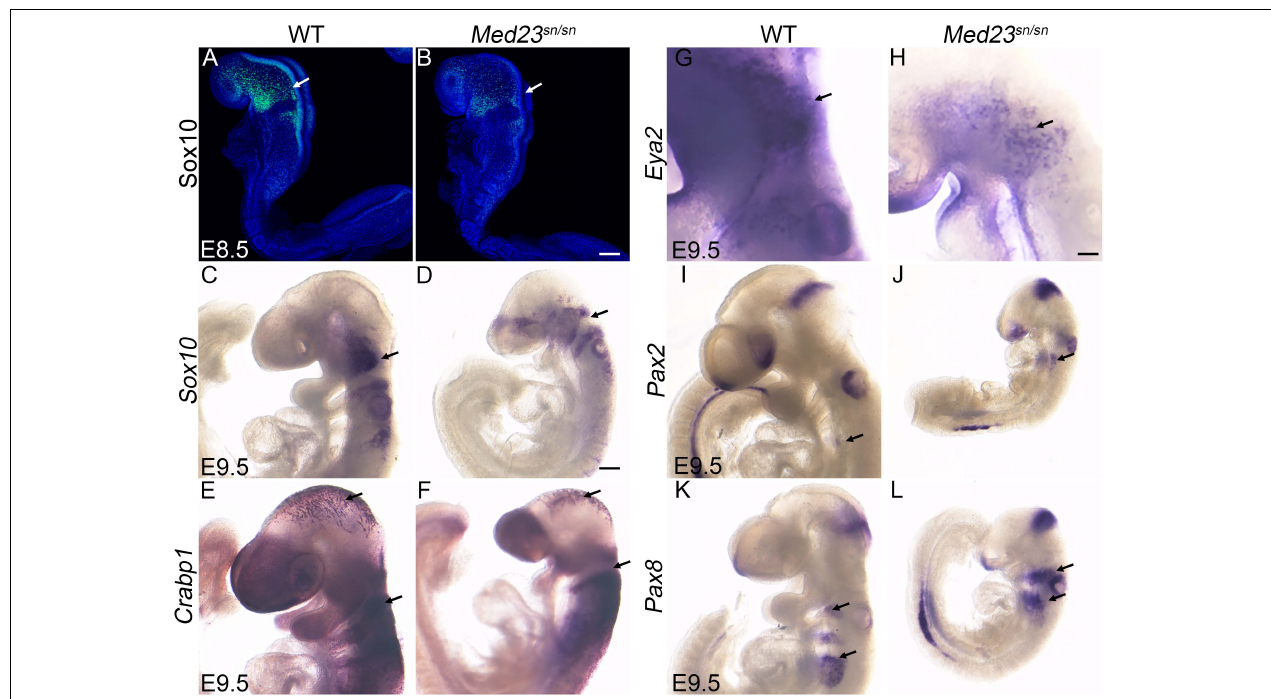
FIGURE 3 | Med23 sn / sn mutants display neural crest cell and placodal defects. (A–D) Sox10 expression in E8.5 and E9.5 control and Med23 sn / sn embryos shows reduced Sox10 + cells entering the cranial ganglia region near the 1 st branchial arch and around the otic vesicle in Med23 sn / sn embryos. (E,F) Crabp1 ISH reveals proper neural crest cell migration in the cranial and trunk regions of E9.5 control and Med23 sn / sn embryos. (G,H) Eya2 expression in control and Med23 sn / sn embryos shows proper formation of anterior pre-placodal area. However, very few Eya2 + cells are observed in the trigeminal and epibranchial regions of Med23 sn / sn embryos (arrow, H ). (I,J) Pax2 + cells are present in the optic, otic, and isthmus of both control and Med23 sn / sn embryos. (K,L) Pax8 + cells are present but loosely organized in the epibranchial region, otic placode and isthmus of Med23 sn / sn embryos in comparison to controls. Scale bar for (A,B) is 120 um, (C–F,I–L) is 300 um, and (G–H) is 150